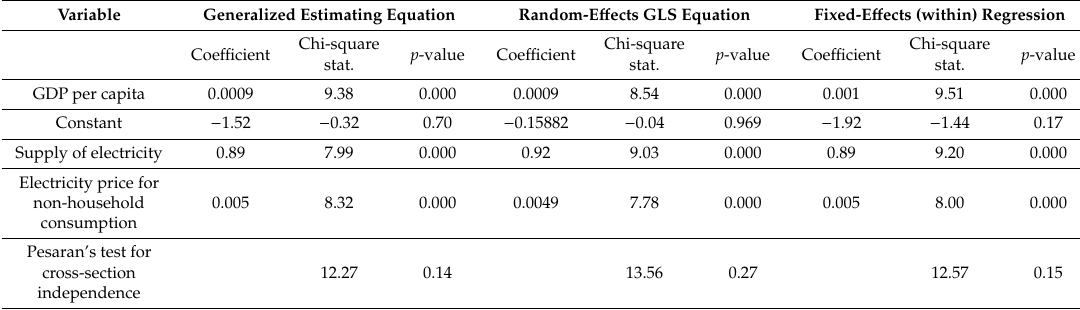
Table 1. Panel data models to explain the share of renewable energy in electricity in the EU member states